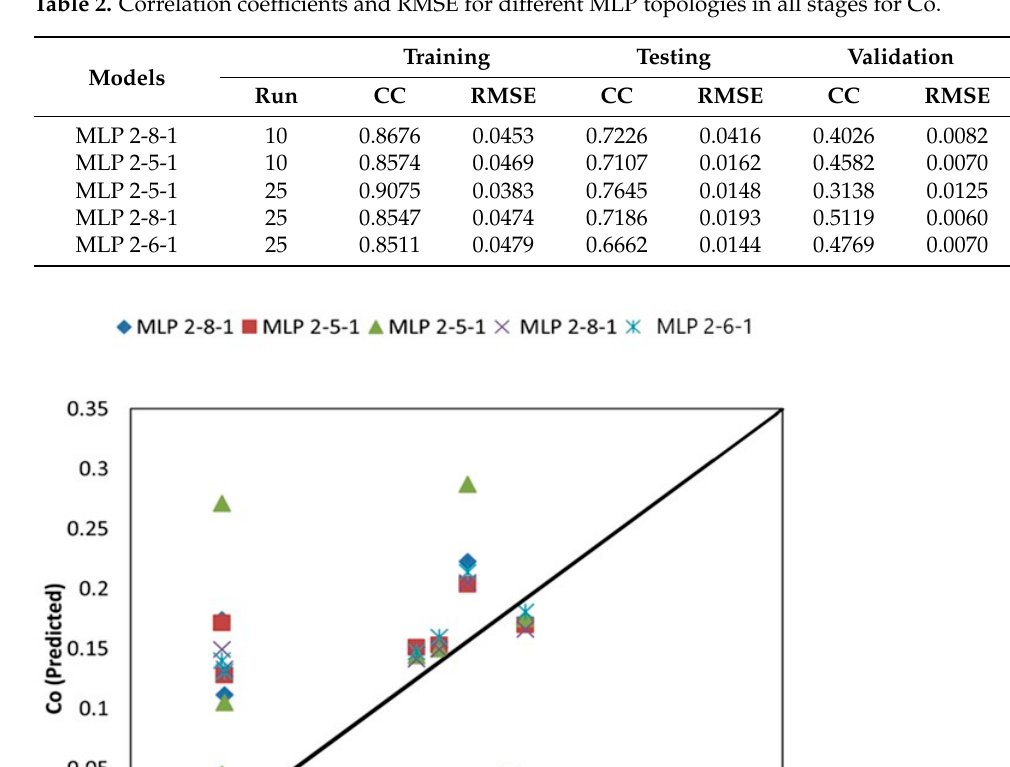
Table 2. Correlation coefficients and RMSE for different MLP topologies in all stages for Co.